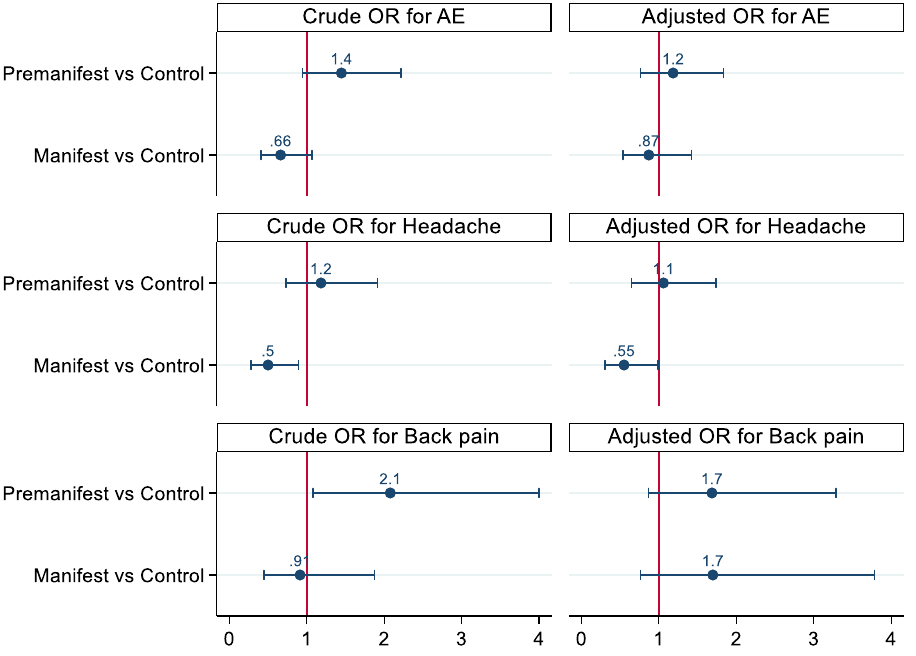
Figure1. Odds ratio and 95%CI of adverse events in premanifest and manifest participants when compared to control participants. OR odds